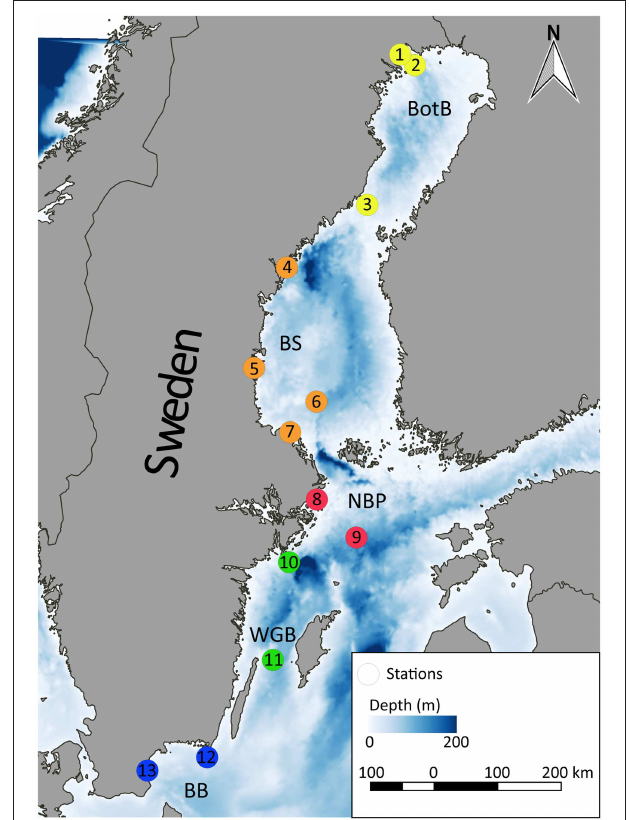
FIGURE 1 | Sampling sites within the Swedish National Monitoring Program for Contaminants in Marine Biota included in this study, BotB: Bothnian Bay (yellow), BS: Bothnian Sea (orange), NBP: Northern Baltic Proper (red), WGB: Western Gotland Basin (green), and BB: Bornholm Basin (blue). 1: Rånefjärden, 2: Harufjärden, 3: Holmöarna, 4: Gaviksfjärden, 5: Långvindsfjärden, 6: Bothnian Sea, offshore site, 7: Ängsskärsklubb, 8: Lagnö, 9: Baltic proper, offshore site, 10: Landsort, 11: Byxelkrok, 12: Utlängan, and 13: Western Hanö